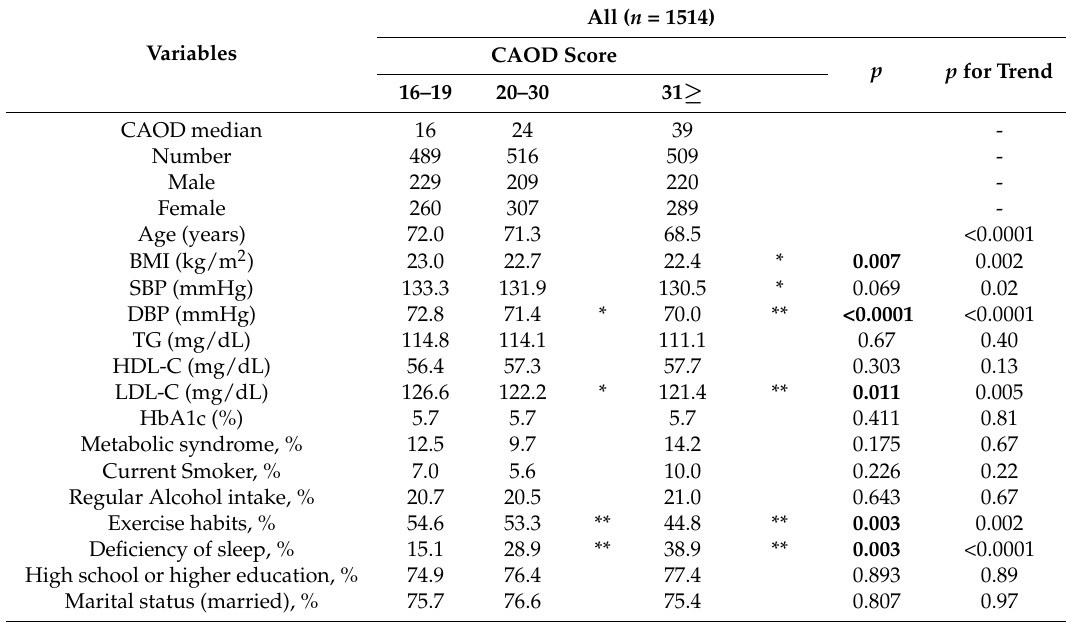
Table 1. Mean age, age- and sex-adjusted mean values, prevalence of clinical parameters, and lifestyles of